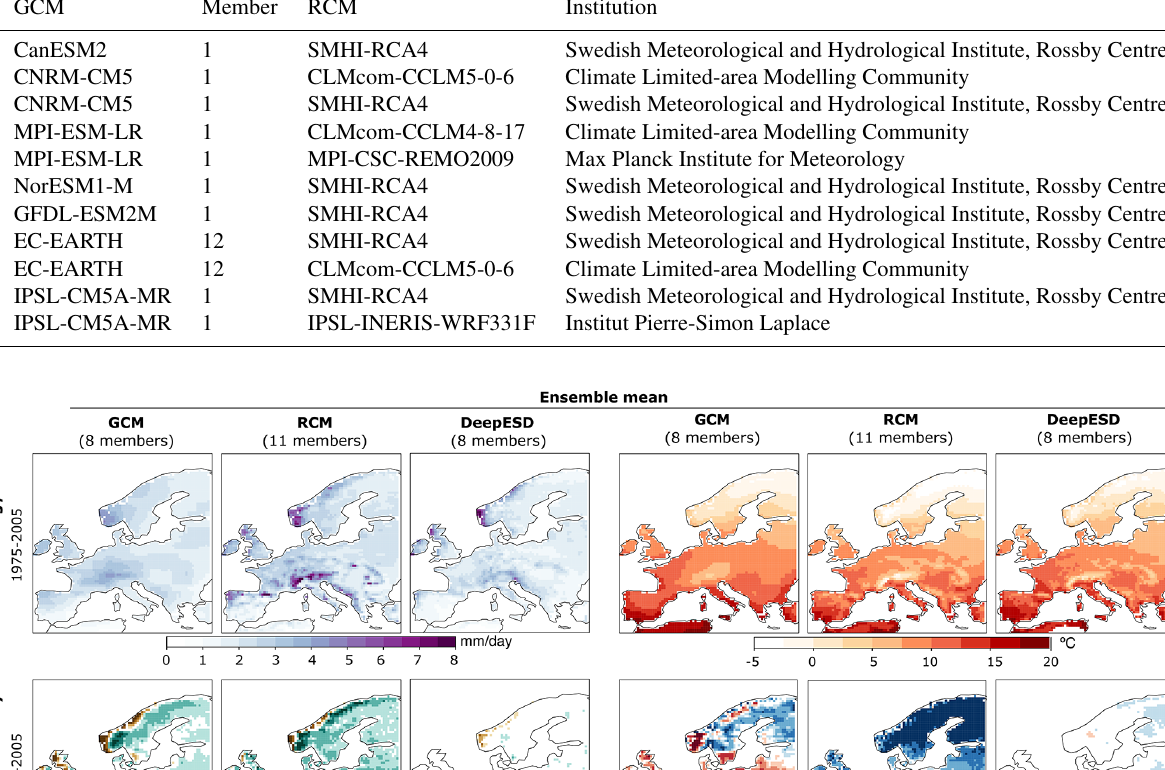
Eastern Europe, especially when compared with GCMs.